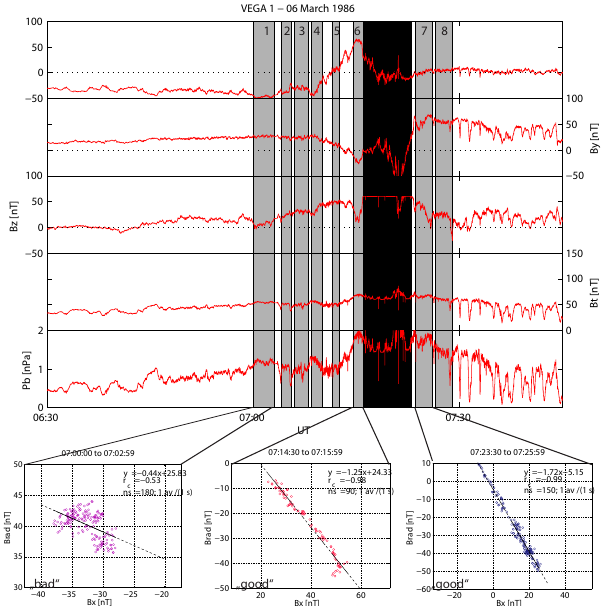
Figure 13. Top panel: the magnetic field data from VEGA 1 with Fig.13. Toppanel: ThemagneticfielddatafromVEGA1withtheeightintervalsforwhichfieldlinedraping wasstudiesmarkedingray. Theblackareashowstheregionwherethemagetometerwassaturatedandwhich the eight intervals for which field line draping was studies marked in was excluded from analysis. Bottom panels: Field line draping fits, according to Eg. (3) for three intervals: a gray. The black area shows the region where the magnetometer was “bad”fitwith ;andtwo“good”fitwith pre-andpost-closestapproachrespectively. | rc | ≤ 0 . 8 | rc | ≥ 0 . 8 saturated and which was excluded from analysis. Bottom panels: field line draping fits, according to Eq. (3) for three intervals: a bad fit with | rc | ≤ 0 . 8; and two good fits with | rc | ≥ 0 . 8 pre- and post- closest approach, respectively.